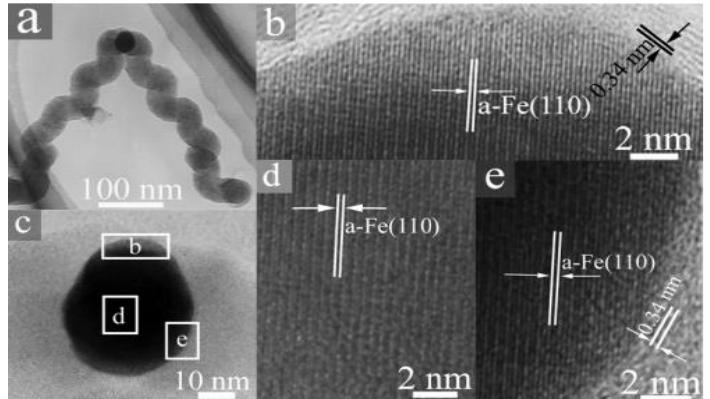
Figure 5. Microstructure of a catalyst nanoparticle located at the node of HCNFs; ( a ) transmission electron microscopy (TEM) image; ( c ) high resolution